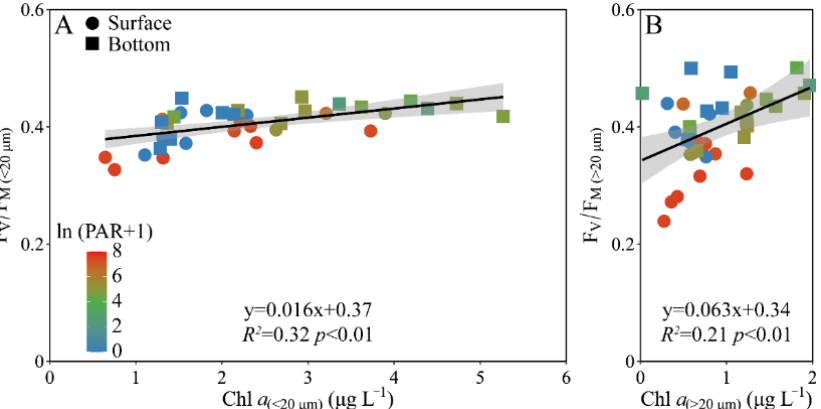
Figure 6. Pairwise relationship between the F V /F M and cell-size-fractioned Chl a (µg L − 1 ) of piconano- ( A , <20 µm) and micro-cell assemblies ( B , >20 µm) in surface and bottom layers of experimental site. Solid lines show the linear regression with shadow indicating 95% confidence interval; and the color in symbol indicates the ln(PAR + 1) wherein the PAR is the cell-received irradiance in field condi- tion. Based on the RDA results, phytoplankton biomass (Chl a ) and photosynthetic param- eters (F V /F M , α and rETR max ) of both piconano- and micro-cell assemblies were positively correlated to the temperature, salinity and pH, as well as the N:P ratio (Figure 7). Moreo- ver, the F V /F M , α and σ PS II were negatively correlated to the solar PAR, indicating the pho- toinactivation of PS II under high light.